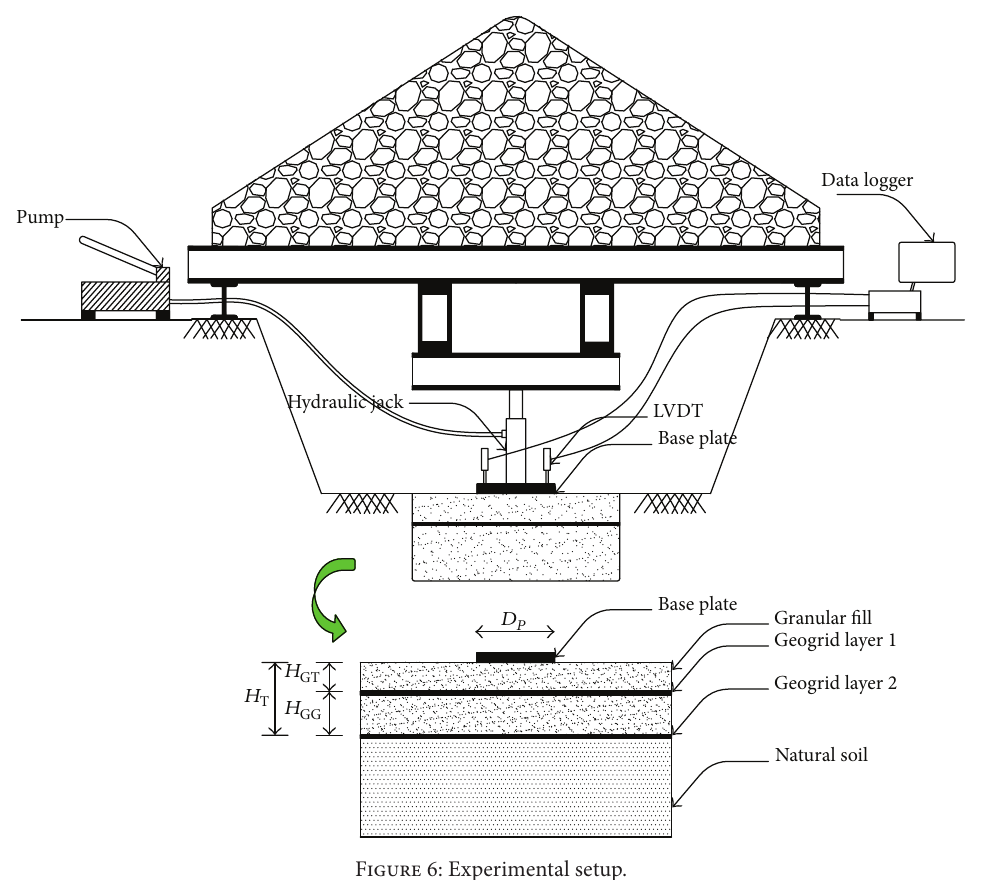
Figure 6: Experimental setup.